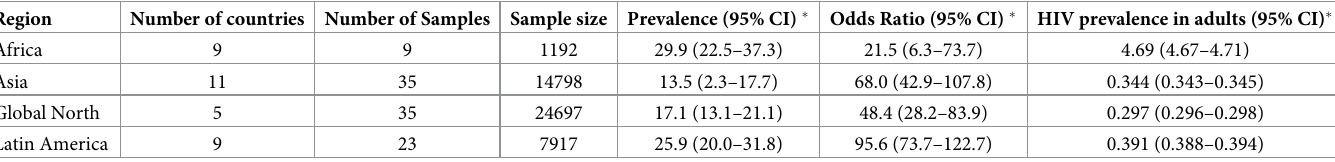
Table 4. HIV prevalence and odds ratios for trans feminine individuals compared to all adults (age 15+), separated by geographic region.